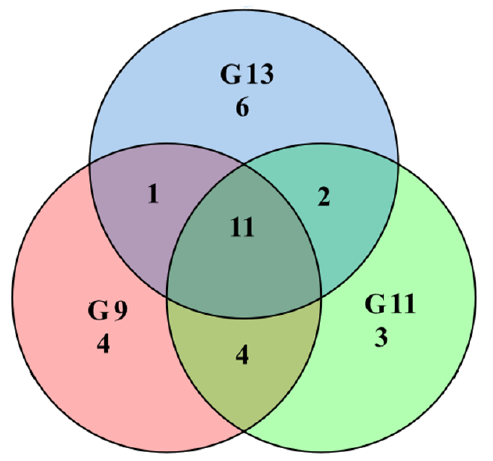
Figure 6. Wayne diagram of excellent growth clones selected at the ages of 9, 11 and 13. G9 ( ), G11 ( ) and G13 ( ) represent 20 excellent clones selected according to the comprehensive evalu- ation of growth traits at the ages of 9, 11 and 13, respectively.